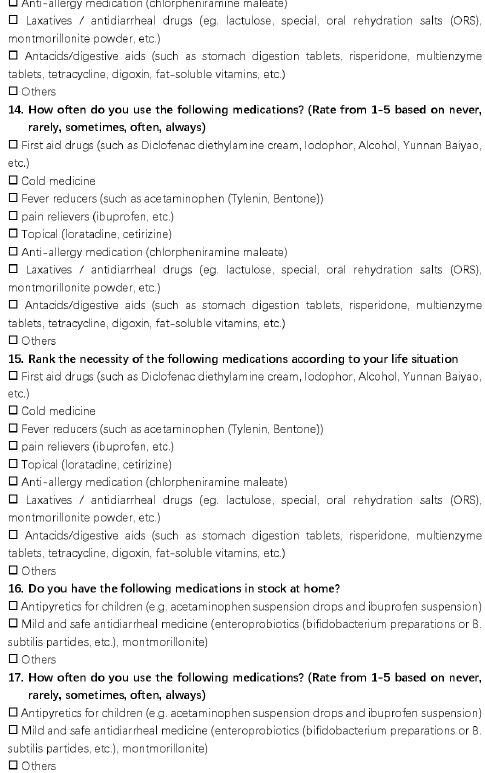
Figure 1. The detail of the questionnaire.